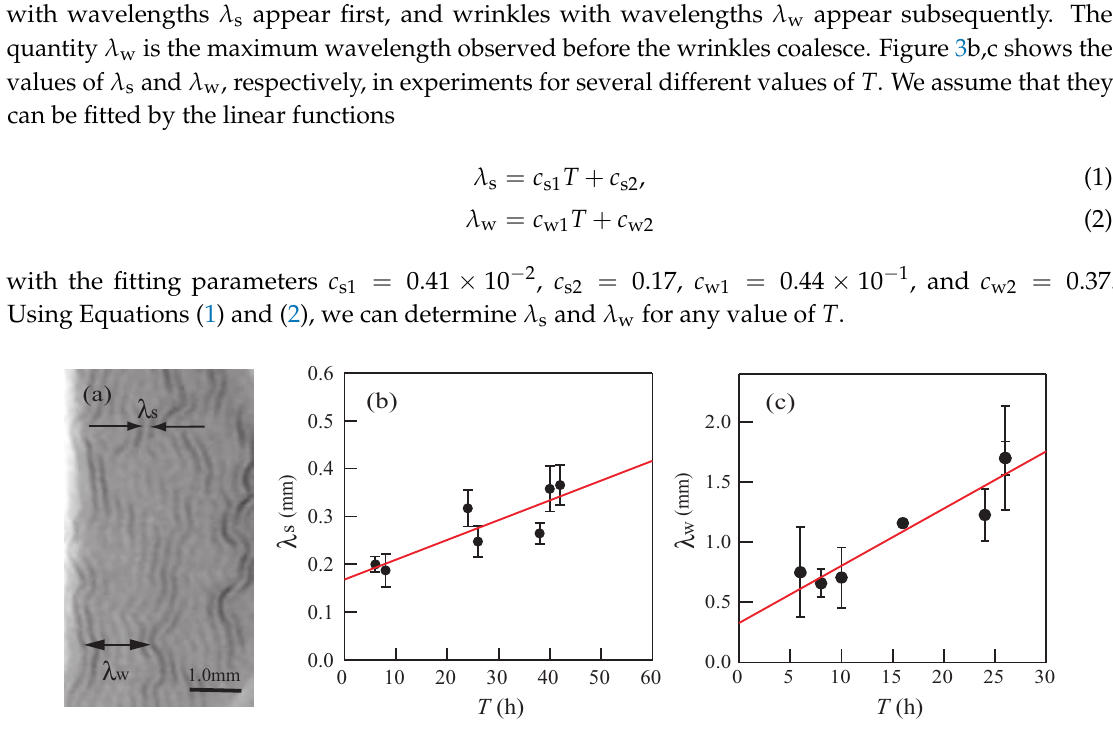
Figure 3. ( a ) Snapshot taken at t = 63 s in the experiment with elapsed time T = 24 h. The short-scale wavelength λ s of the small wrinkles and the wavelength λ w of the larger-scale wrinkles are indicated. The solid line in the photo shows a 1.0-mm-scale bar. Panels ( b , c ) show the quantities λ s and λ w obtained from our experiments for several different values of T . The closed circles are the experimental data, and the solid lines in ( b , c ) are the fitted lines given by Equations (1) and (2), respectively.